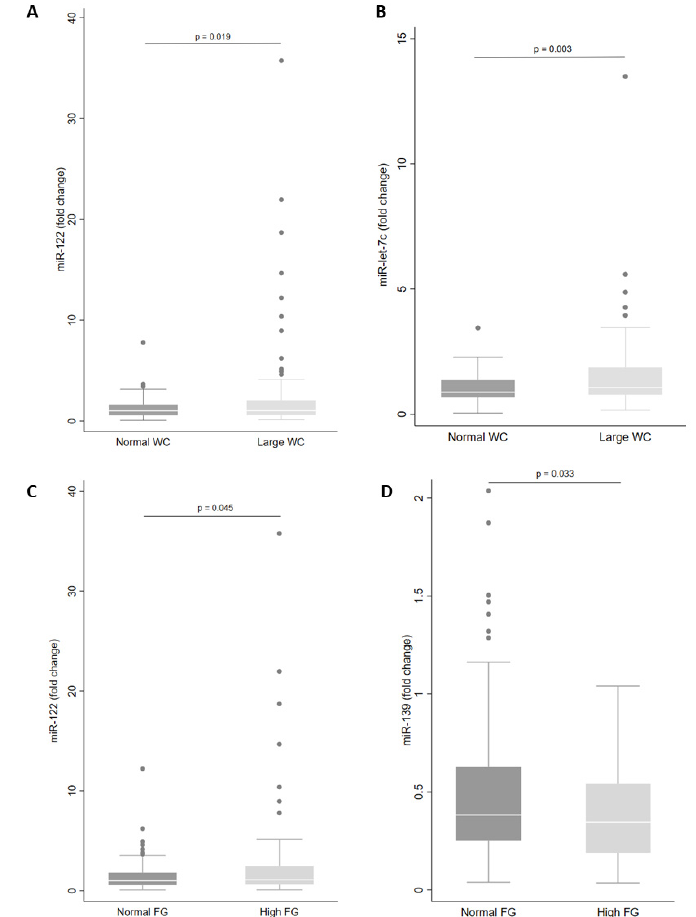
Figure 3. Levels of miRNA in plasma according to waist circumference (WC) ( A , B ) and fasting glucose (FG) status ( C , D ). The sample sizes were as follows: miR-122 and miR-let-7c (Normal WC n = 62|Large WC n = 130); miR-122 (Normal FG n = 131|High FG n = 61) and miR-139 (Normal FG n = 101|High FG n = 41). Comparisons between groups in miRNA levels were conducted using the adjusted Wald test. The box plots depict the 25th–75th percentile, and the white line represents the median of each group. p < 0.05 indicates statistically significant differences. Table 3. Altered levels of miRNAs according to sex and individual components of the metabolic syndrome (MetS) in adults from a population-based